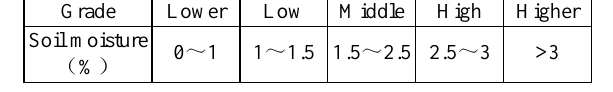
Table 3. The divided grades of soil moisture levels